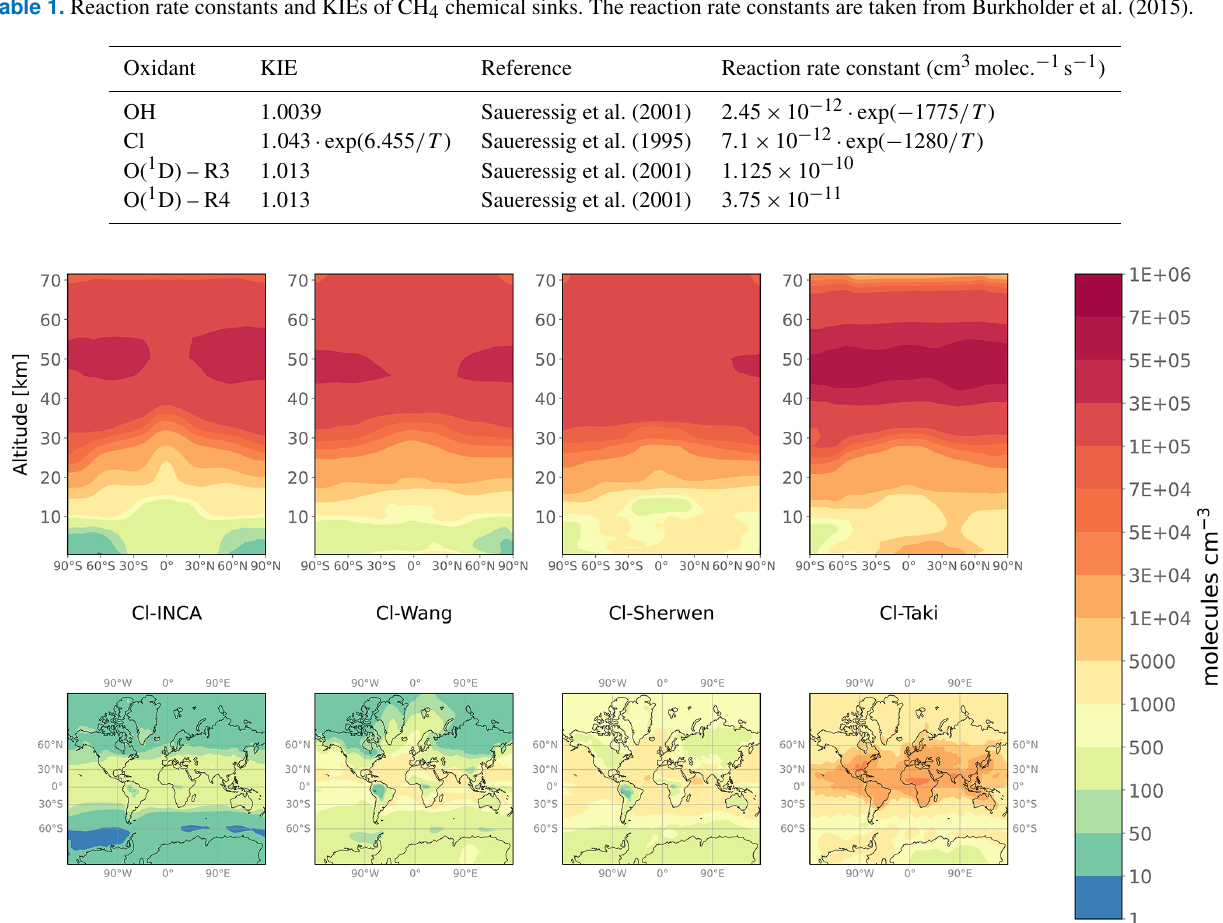
Figure 1. Annual mean meridional cross section (upper panels) and tropospheric Cl concentrations (lower panels) for the four 3-D fields Cl-INCA, Cl-Wang, Cl-Sherwen, and